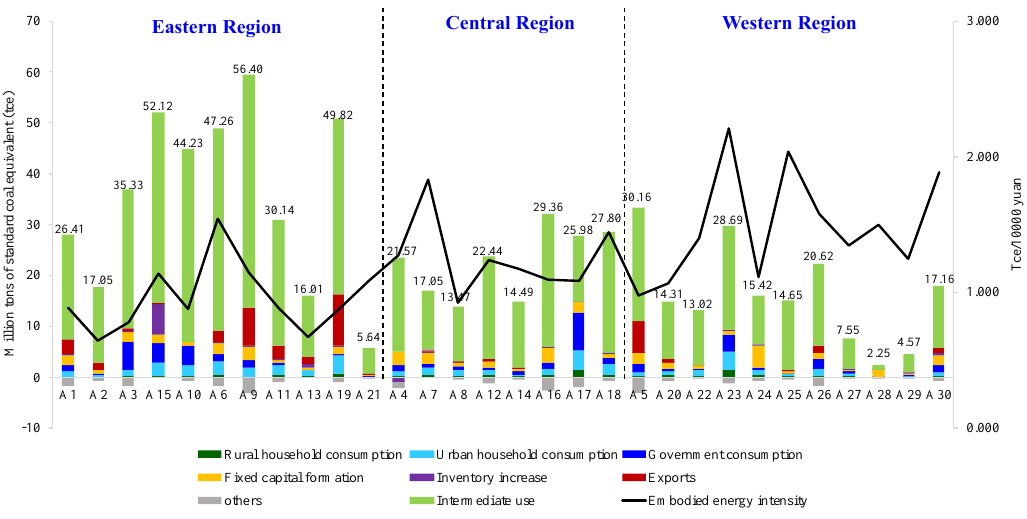
Figure 2. Energy consumption embodied in the transport sector from the perspective of different use.